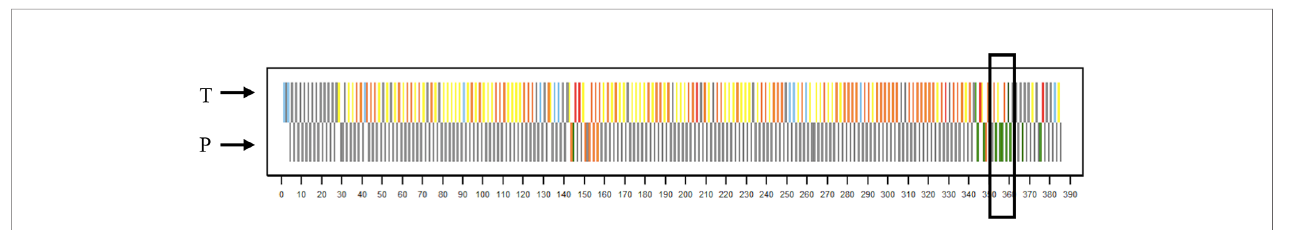
FIGURE 2 | Visual Visual overview of session 1, case 12. Overview of sequentially coded session. Colored bars therapist verbal behavior: dark green = question querying for change, or two-sided question; light green = re fl ection of change talk, or two-sided re fl ection; yellow = question querying counter-change, or question not directed at target behavior; orange = re fl ection of sustain talk, or re fl ection of neutral talk; blue = sequential MI-consistent techniques (af fi rm, emphasize control, permission seeking, support); red = MI-inconsistent techniques (confront, direct, warn, opinion, advice without permission); gray = other techniques. Colored bars patient verbal behavior: green = change talk; orange = sustain talk; gray = neutral. On the axis, the sequential utterance number is displayed. The line in the black rectangle shows the session part displayed in Box 4